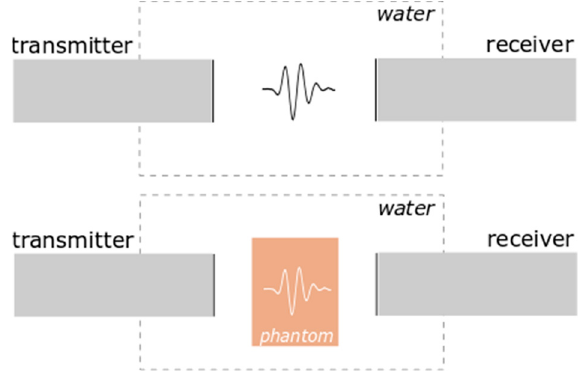
Figure 2. Experimental setup for ultrasonic wave velocity measurements.